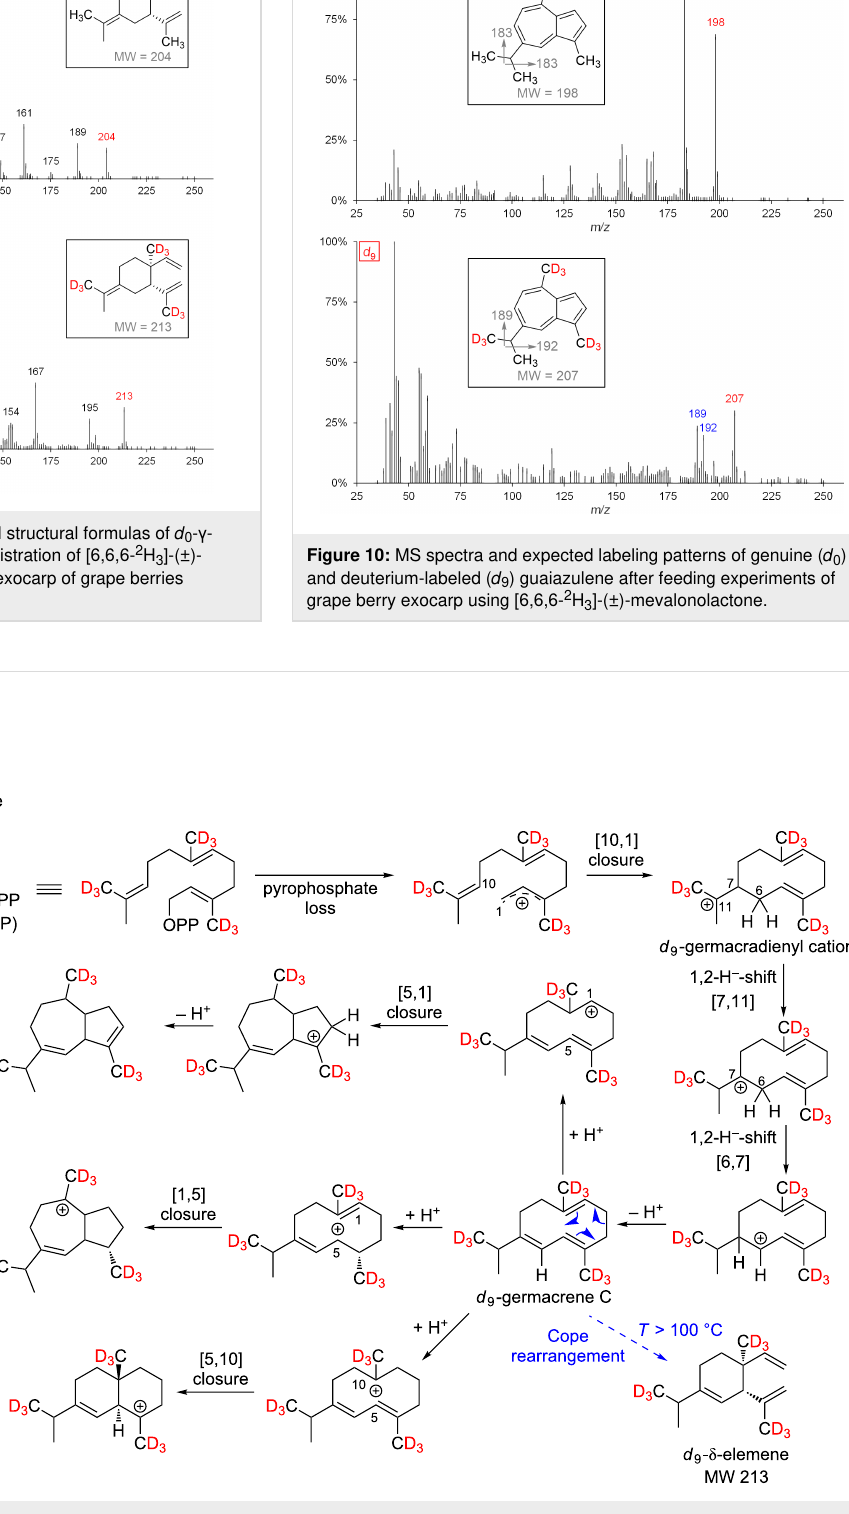
Scheme 7: Possible synthesis of d 9 -guaiazulene, d 9 - δ -elemene, d 9 -guaia-6,9-diene and d 9 - δ -selinene via germacrene C after administration of [6,6,6- 2 H 3 ]-(±)-mevalonolactone ( d 3 -MVL) to isolated exocarp of grape berries (Lemberger cultivar).